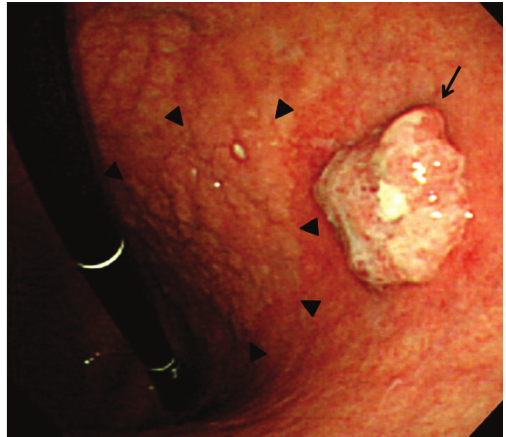
Figure 1: EGD showed a small protruded lesion (0-I) on the lesser curvature of the lower gastric body (arrow), and a large superficial elevated lesion (0-IIa) on the lesser curvature of the stomach which spread from the upper to the lower gastric body was also visualized (arrowheads).